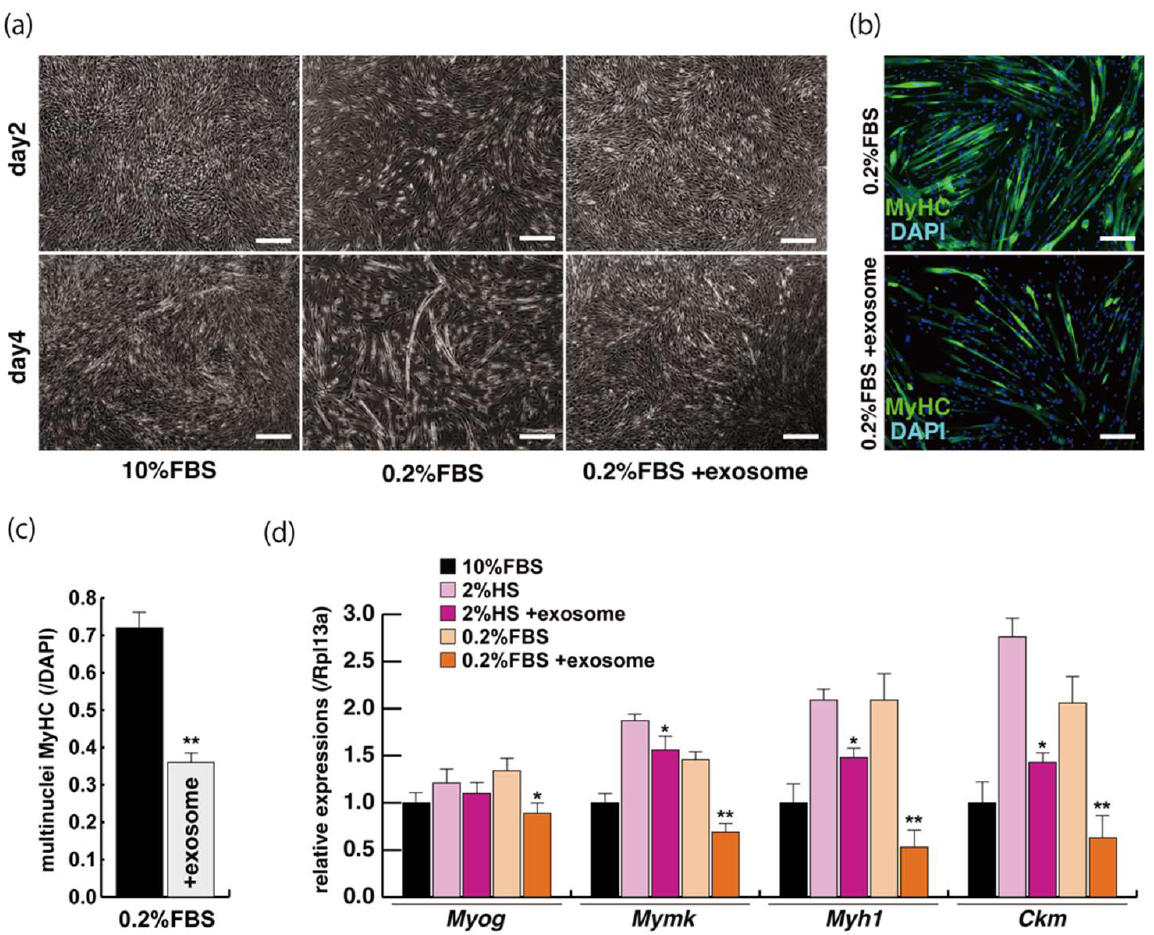
Figure 2. Addition of exosomes derived from serum affects myogenic differentiation. ( a ) Approximately 80% of semi-confluent C2C12 cells with 10% or 0.2% of fetal bovine serum (FBS) with or without additional exosomes; ( b ) differentiated C2C12 cells (day4) were immunostained with anti- MF20 (MyHC, green). All nuclei were stained with 4′6-diamidino-2-phenylindole (DAPI, blue); ( c ) the ratio of DAPI-positive multinuclei staining present in single MyHC-positive myofibers with or without additional exosomes; ( d ) relative expression of myogenic differentiation ( Myog ), fusion ( Mymk ), and differentiated markers ( Myh1 , Ckm ) in C2C12 cells cultured in FBS with or without additional exosomes. All Scale bar = 100 μm. Data represent means ± SEM ( n = 3). The statistical analysis was performed with Mann–Whitney U test. * p < 0.05, ** p < 0.01.